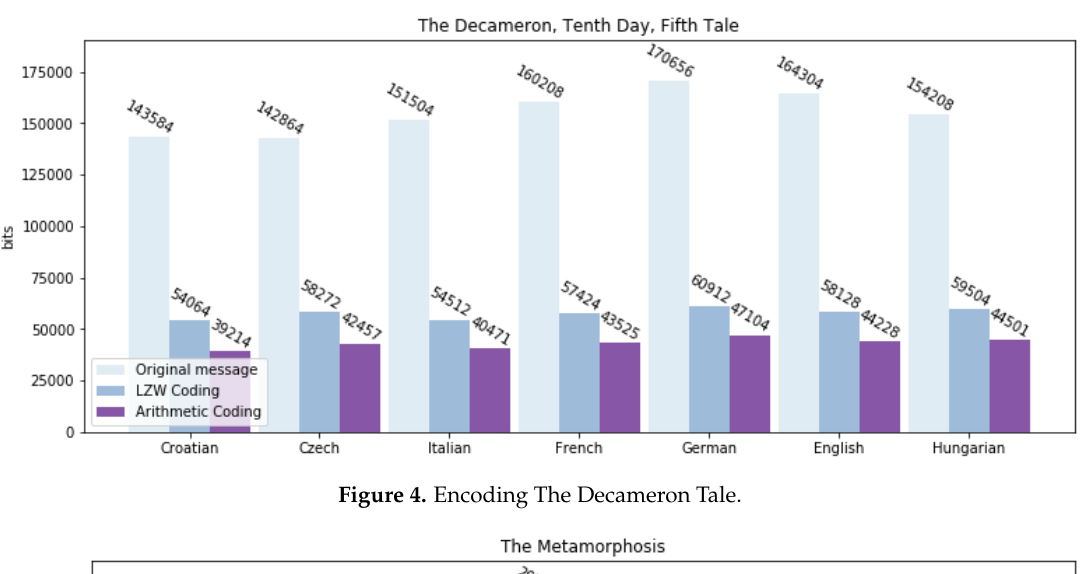
Figure 3. Encoding The Little Match Girl.